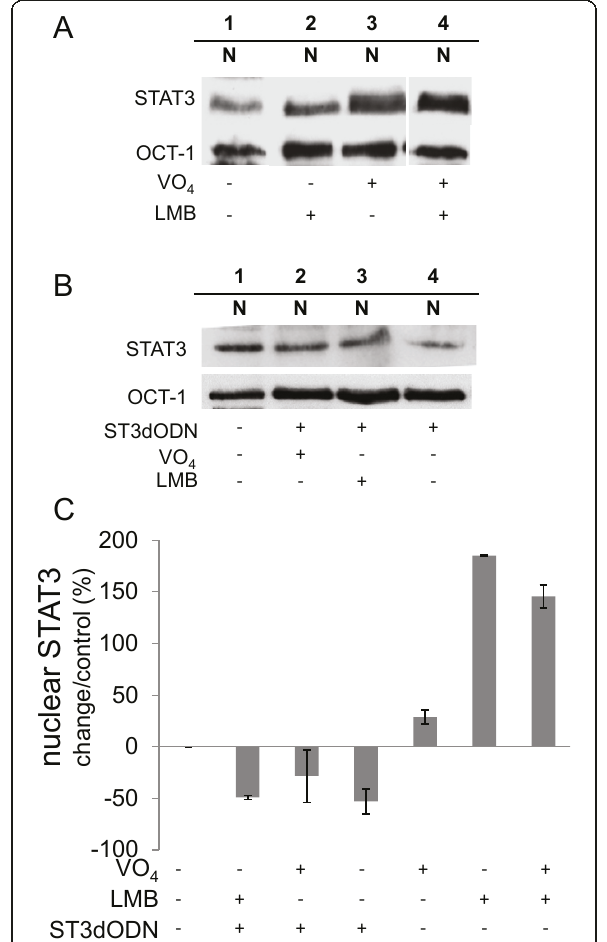
that the basal levels were somewhat higher (Figure 9C).